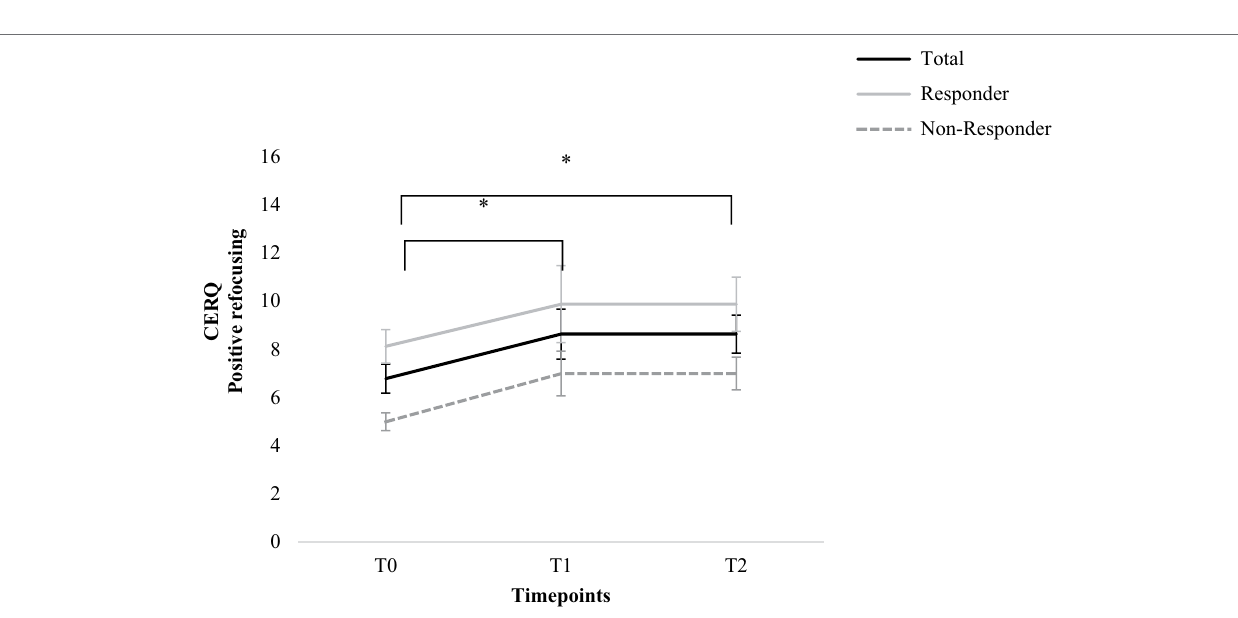
FIGURE 5 | Change in the Cognitive Emotion Regulation Questionnaire positive refocusing score for total sample, responders, and non-responders. Error bars represent standard errors. * = p < 0.05 (total